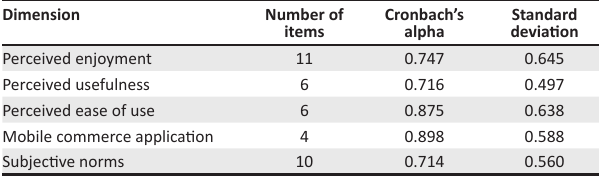
TABLE 2: Cronbach alpha values. Dimension